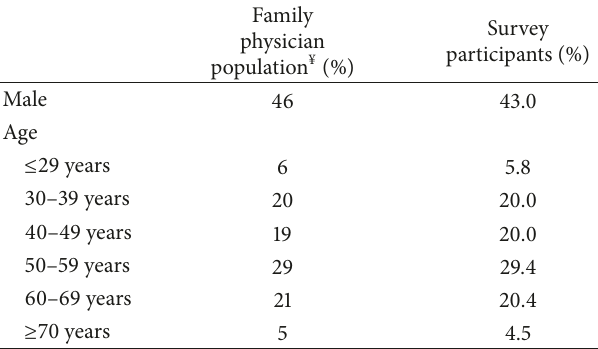
Table 1: Sex and age distribution of the Qu´ebec family physician population and sample ( 𝑁 = 636